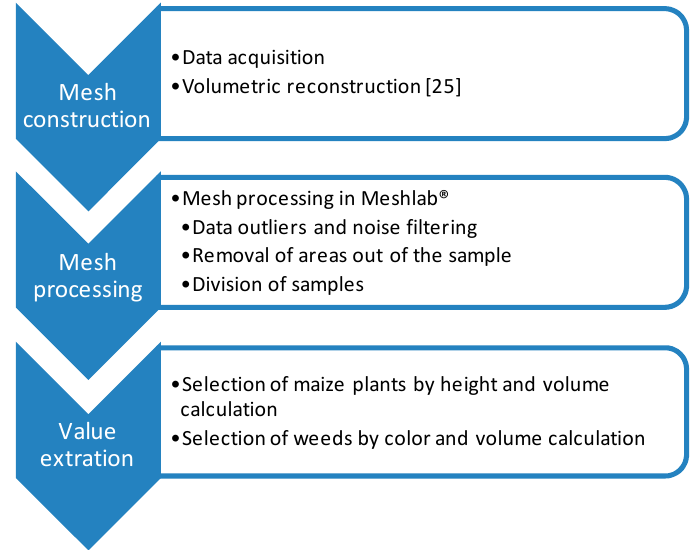
Figure 3. Data processing structure of the Kinect sensor information.